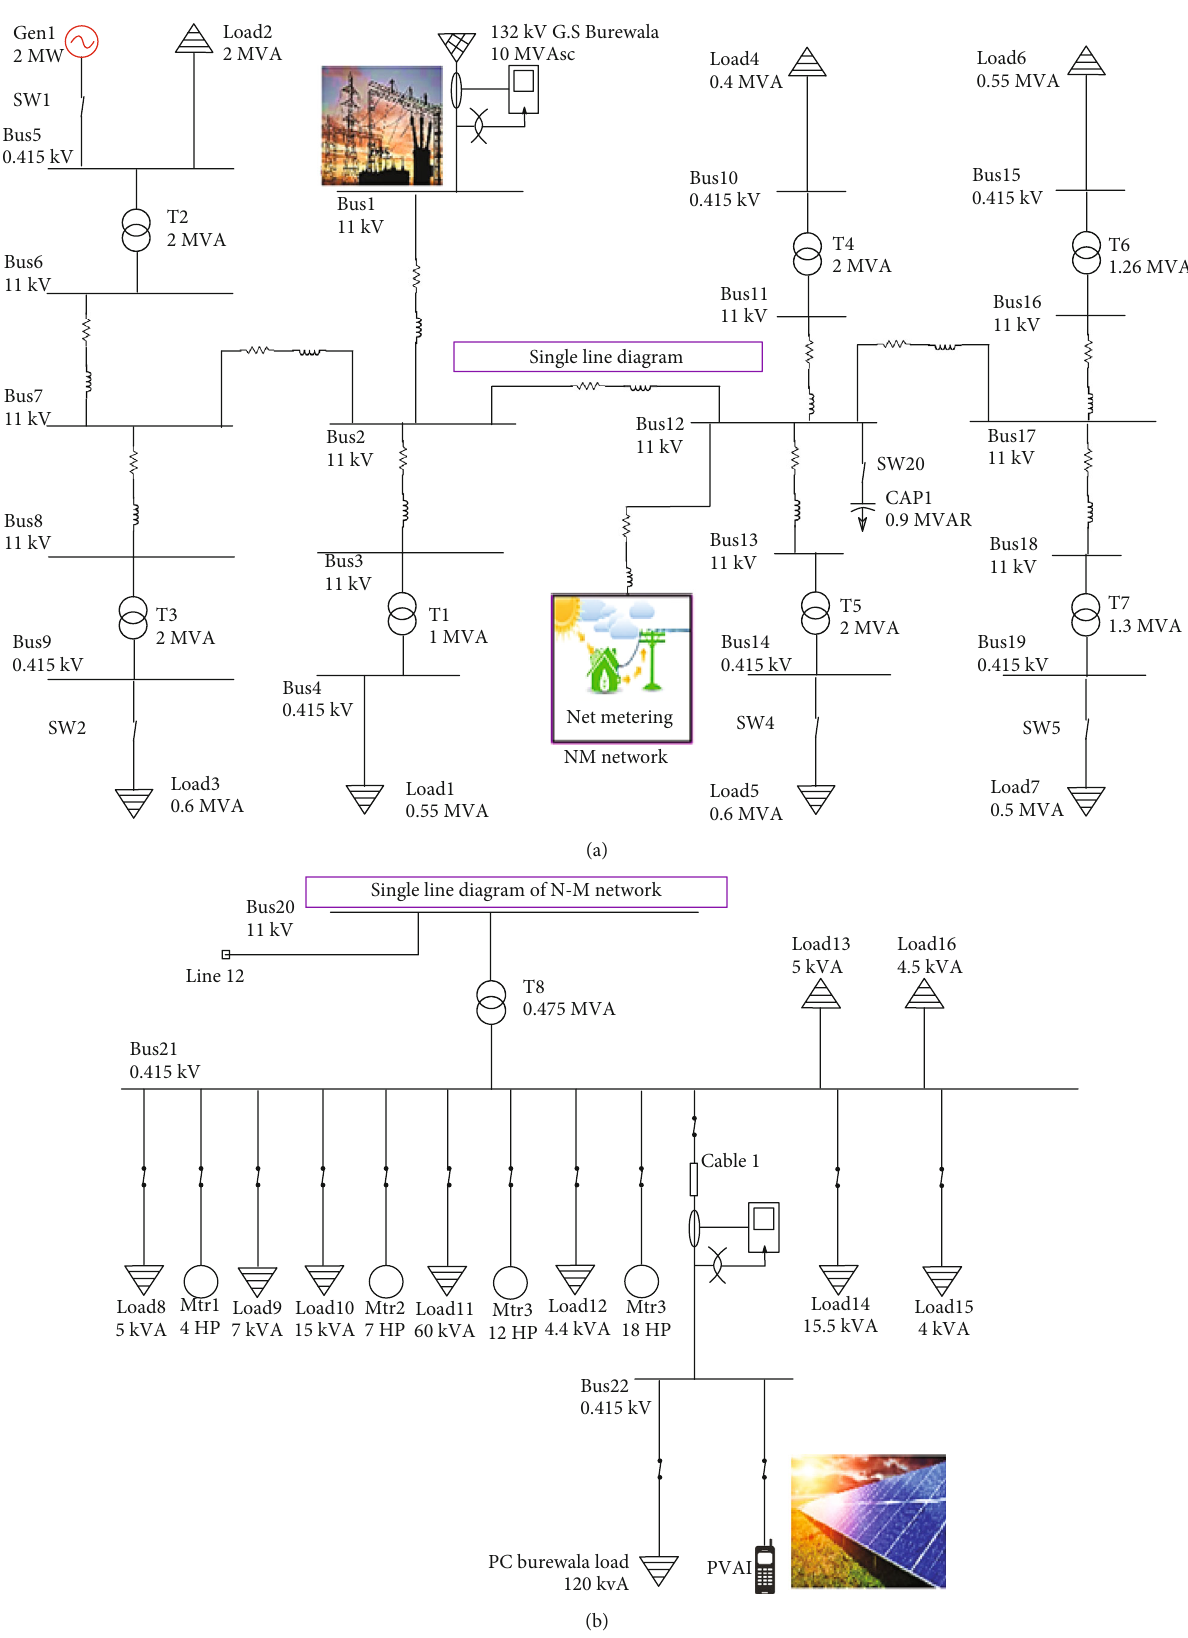
Figure 2: (a) Single line diagram of CITY-3 feeder (MEPCO). (b) Single line diagram of net-metering